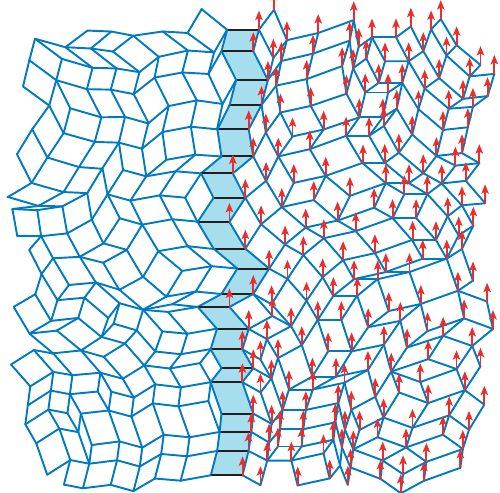
FIG. 3. An example of a bulk FM (red arrows) of a random parallelogram tiling. A strip of parallelograms (light blue) is randomly chosen, and the FM displaces all nodes right to this strip in a direction that is perpendicular to the parallel edges in this